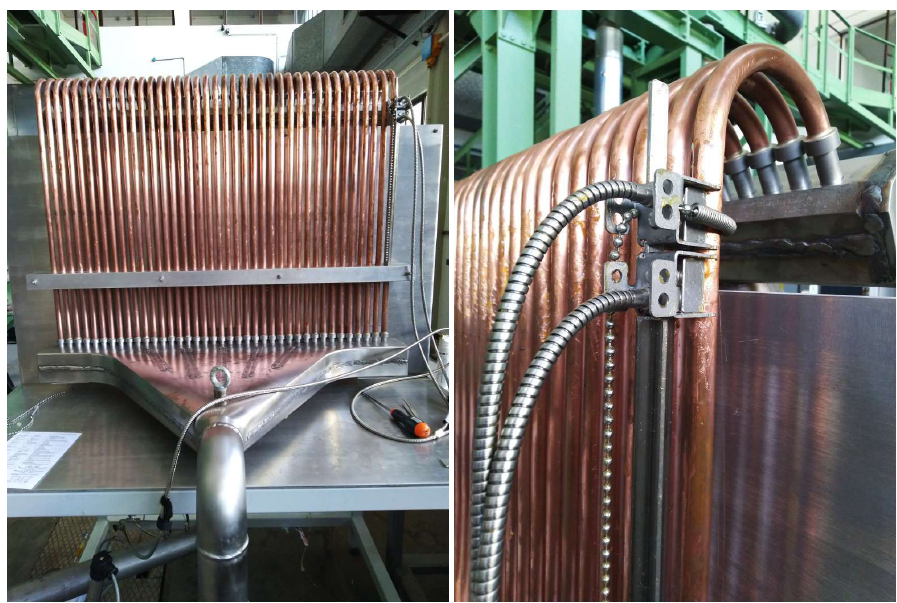
Figure 5. Ultrasonic flow meter measurements on the first OVT plasma facing cooling tubes.